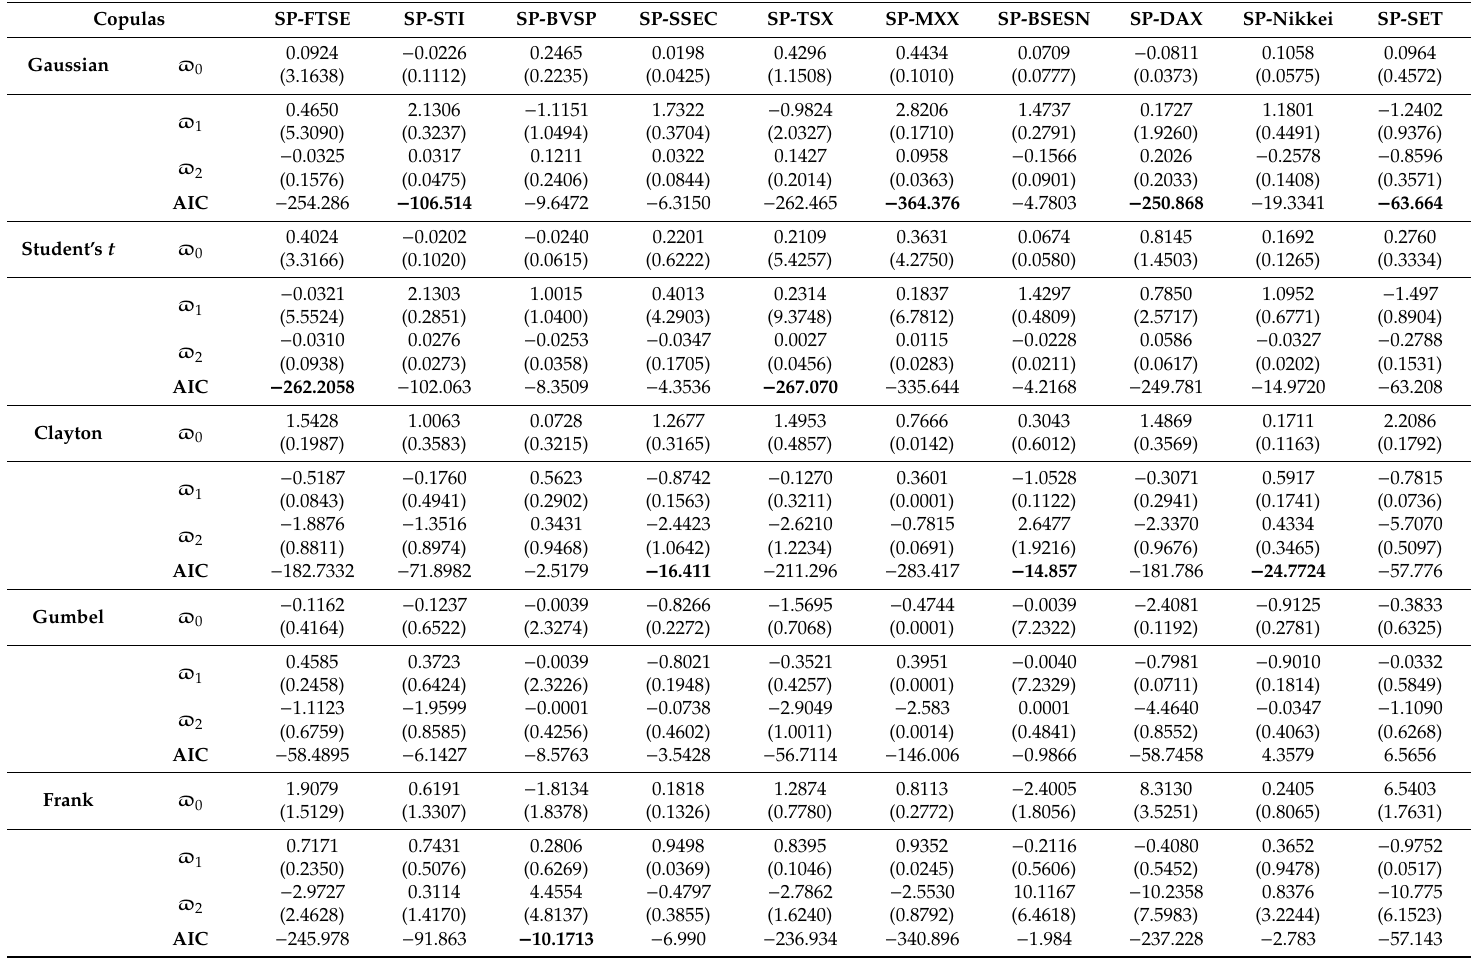
Table 6. Estimation of dynamic copula without abnormal Google index